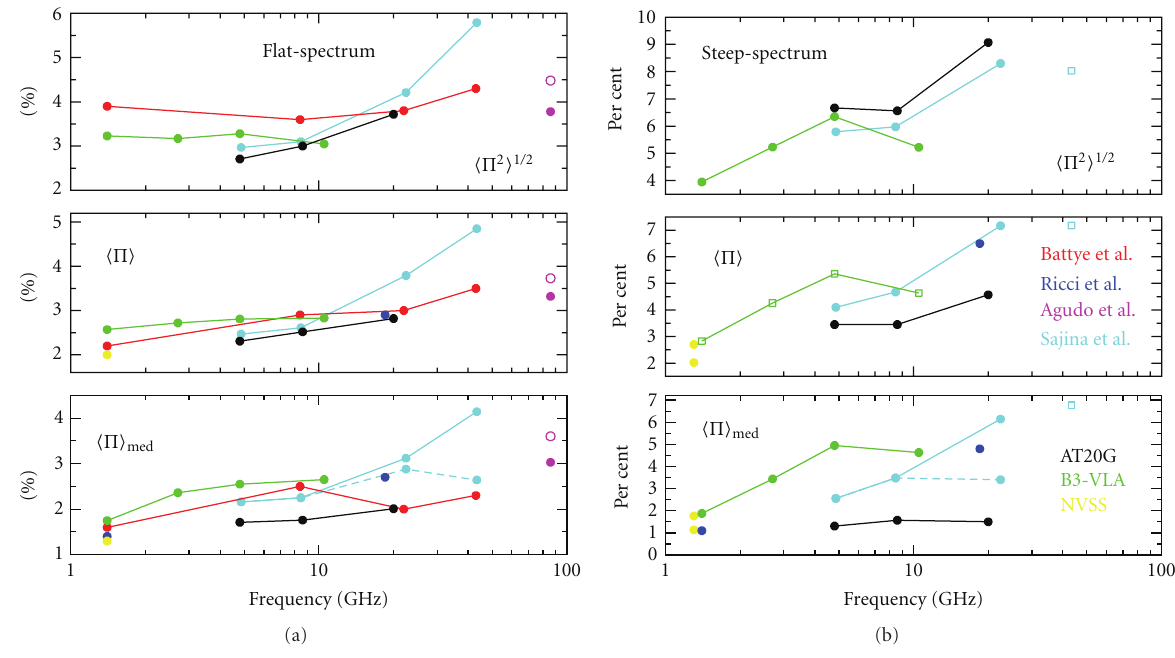
Figure 5: Median, mean, and (cid:9) Π 2 (cid:10) 1 / 2 of fractional polarization for flat- (a) and steep-spectrum (b) sources. Black points refer to the almost complete subsample of the AT20G survey with S c = 500 mJy for flat-spectrum sources and 300 mJy for steep-spectrum sources. Red points refer to data presented in [39]. Green points refer to the B3-VLA sample (with respect to [46], we distinguish flat- and steep-sources on the basis of their spectral index between 1.4 and 5GHz; values shown in the plot are obtained using the ASURV code, taking into account upper limits in the fractional polarization). Cyan points refer to the sample from [50] (see text and Table 2; empty cyan points at 43 GHz for the steep-spectrum have to be considered as upper limits). Blue points refer to results from [51] and magenta points from [49] (solid and empty points are for FSRQs and BL Lacs, resp.). Yellow points refer to the NVSS survey (see [16]): for steep-spectrum sources we plot results for sources with 100 ≤ S < 200mJy and S ≥ 800 mJy.